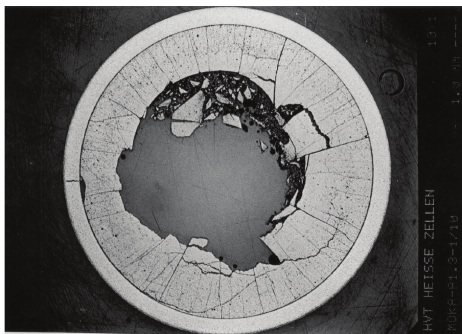
Figure 11: PCI-SCC failure of an experimental PHWR fuel rod prototype. The rod was irradiated at the Petten reactor and the experiment was defined with BaCo [15].